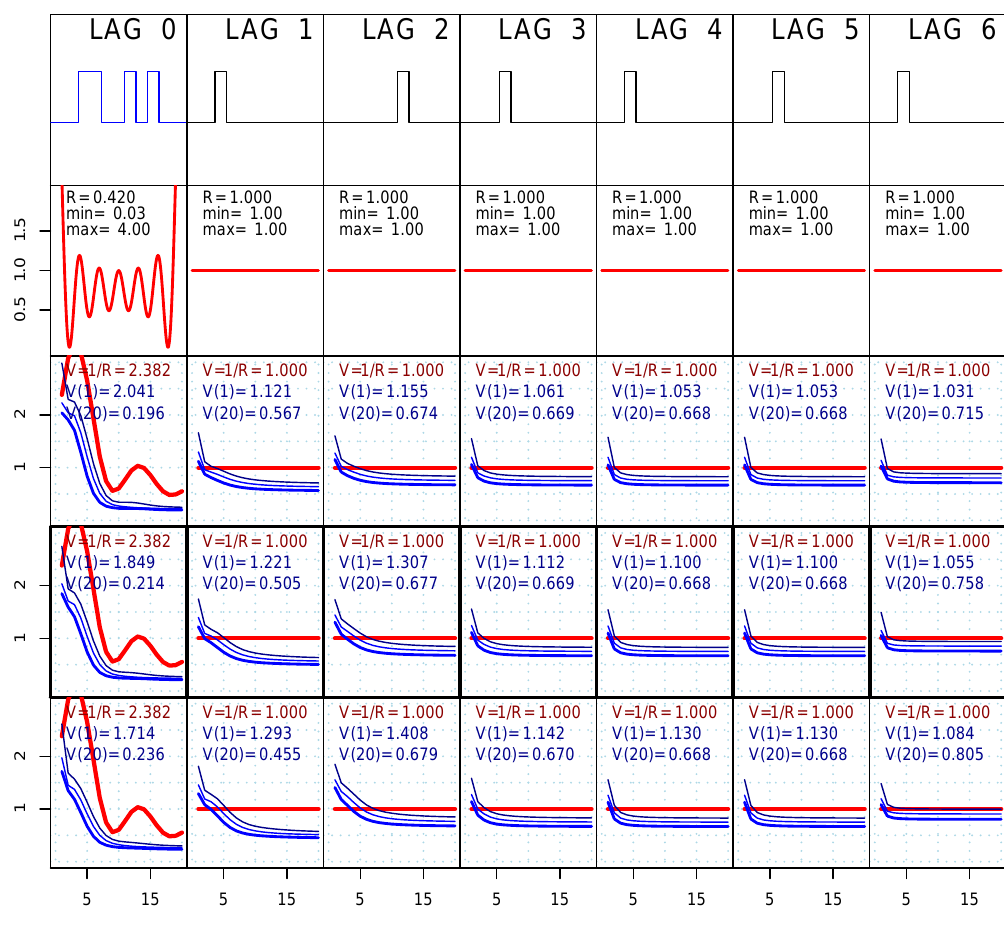
Fig. 2. Evaluation of a simple multiple-pulse type code.